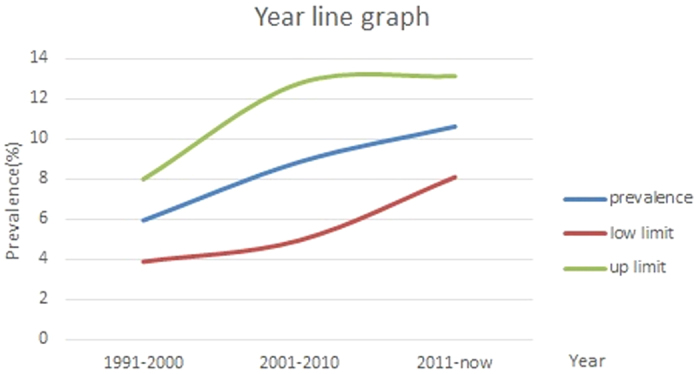
Pooled estimated prevalence of kidney stones in mainland China with corresponding 95% confidence intervals from different survey periods.